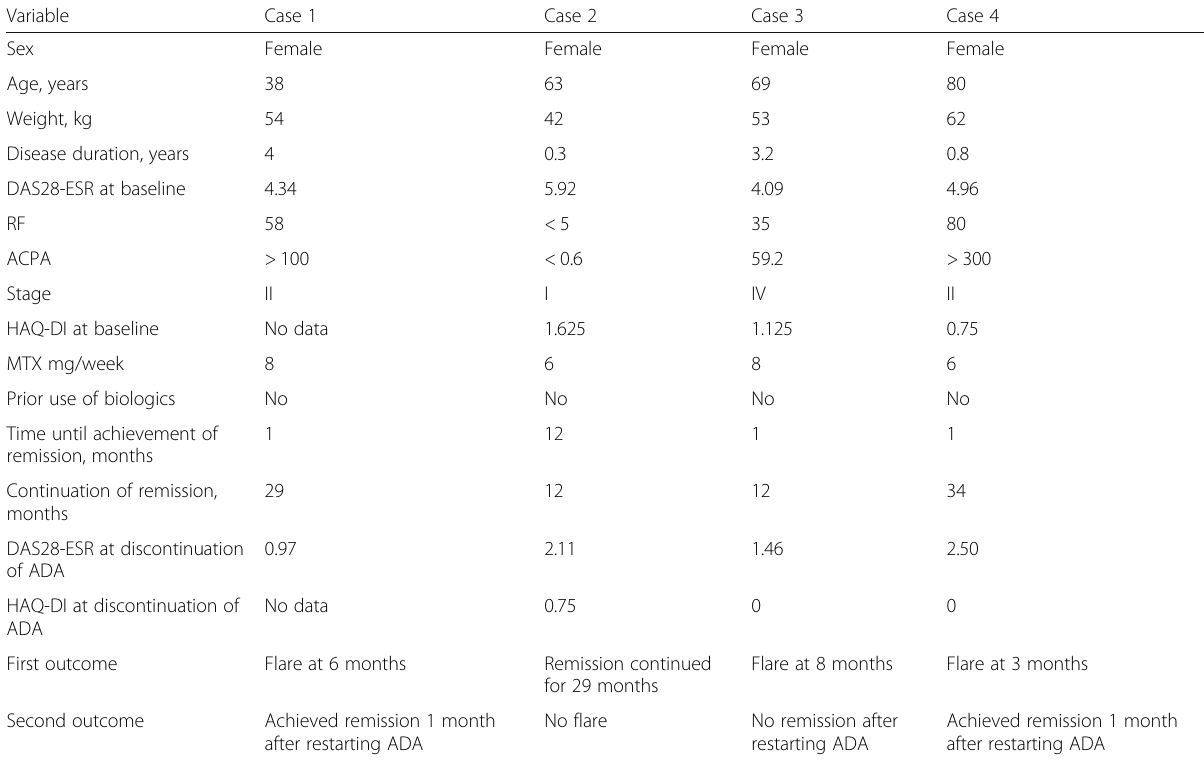
Table 5 Characteristics of four patients who discontinued ADA because of sustained remission